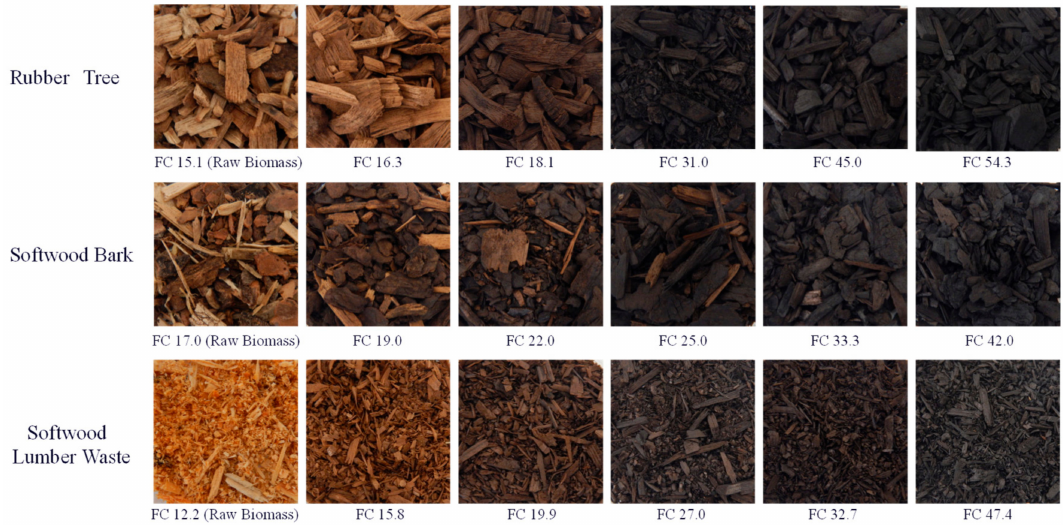
Figure 1. WB color changes observed during carbonization. FC = fixed